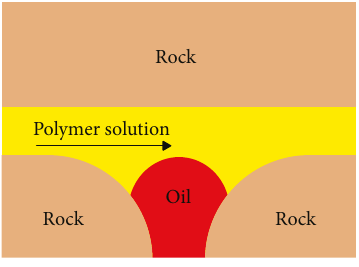
Figure 1: Physical